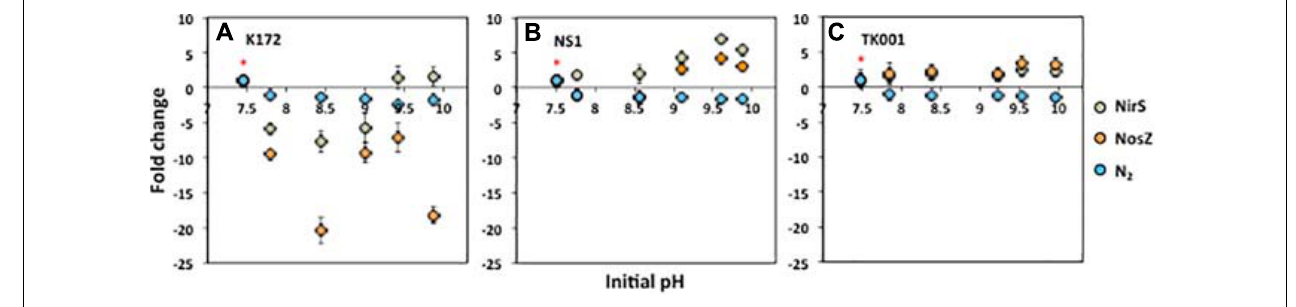
FIGURE 6 | Changes in production of N 2 and expression of denitrification genes (NirS and NosZ) as a function of increasing pH in batch cultures of denitrifying Thauera strains (K172, NS1 and TK001) amended with 1 mmol L − 1 of NO 3 − and acetate. The red star (*) indicates optimum pH-7.5 taken as equivalent to 1 for comparison with high pH conditions. Error bars represent standard errors for three